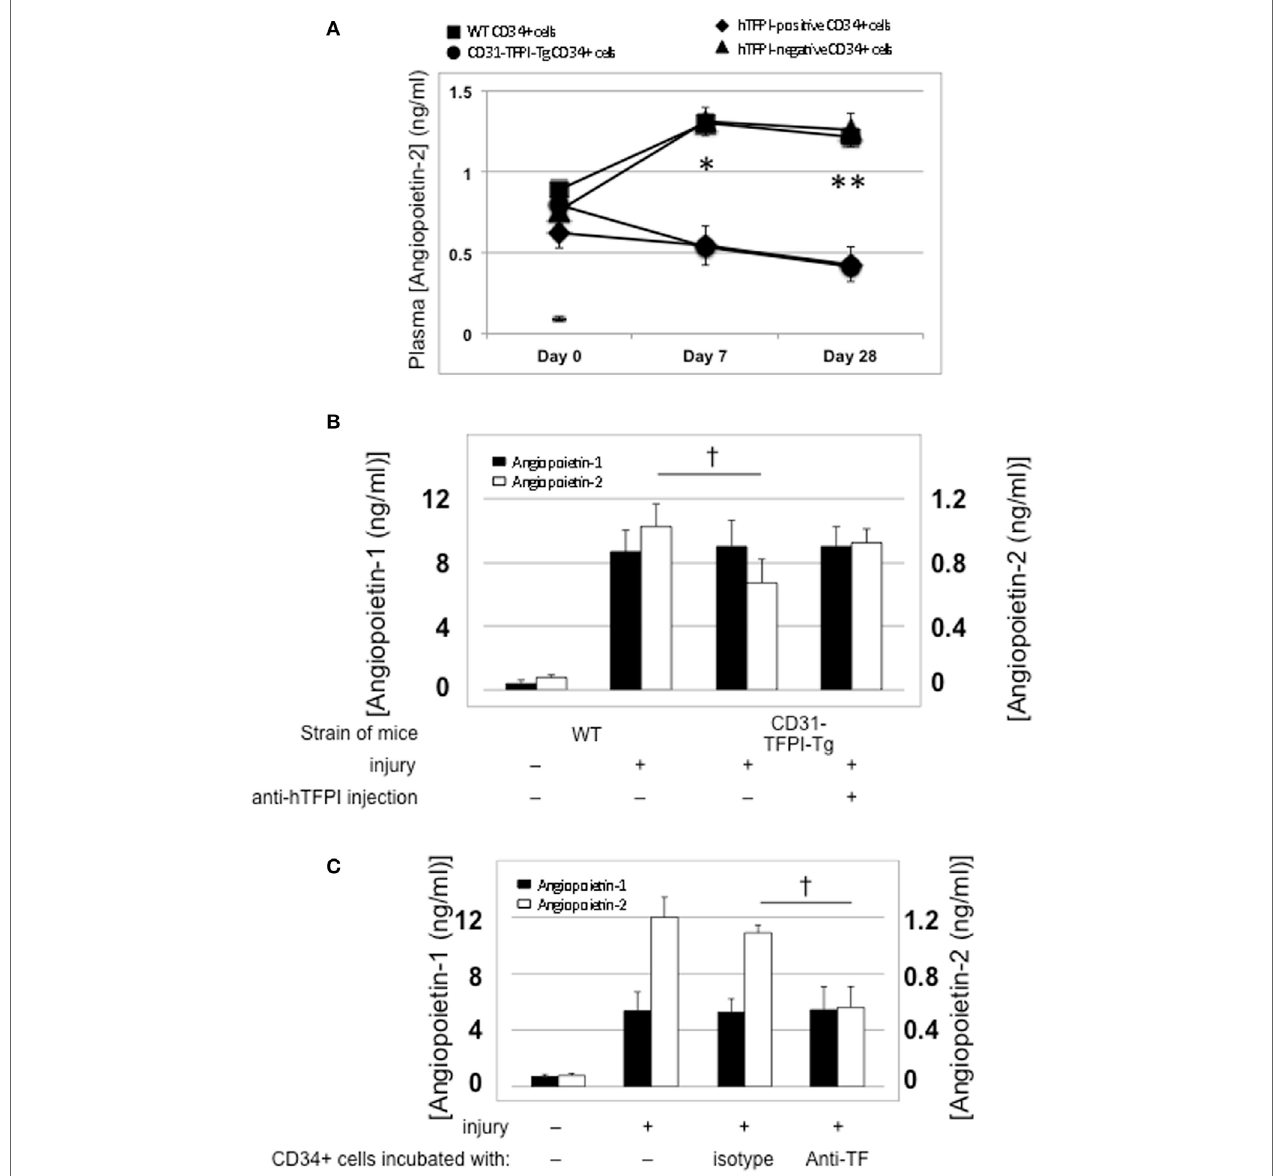
FigUre 5 | Association between intimal hyperplasia and plasma levels of angiopoietin-2 after wire-induced endoluminal injury . (a) Plasma angiopoietin-2 levels in wild-type (WT) mice. Levels in unninjured mice represented by the horizontal bar day 0 only; (squares)—WT CD34 + cells; (circles)—unfractionated CD31-TFPI-Tg CD34 + cells; (diamonds) human tissue factor pathway inhibitor (hTFPI) + fraction of CD31-TFPI-Tg CD34 + cells; (triangles)—hTFPI-negative fraction of CD31-TFPI-Tg CD34 + cells. *Day 7 p < 0.01: WT vs. CD31-TFPI-Tg cells; WT cells vs. hTFPI + fraction; CD31-TFPI-Tg cells vs. hTFPI − fraction and hTFPI − fraction vs. hTFPI + fraction. All other comparisons, p > 0.05. **Day 28, p < 0.01: WT vs. CD31-TFPI-Tg cells; WT cells vs. hTFPI + fraction;